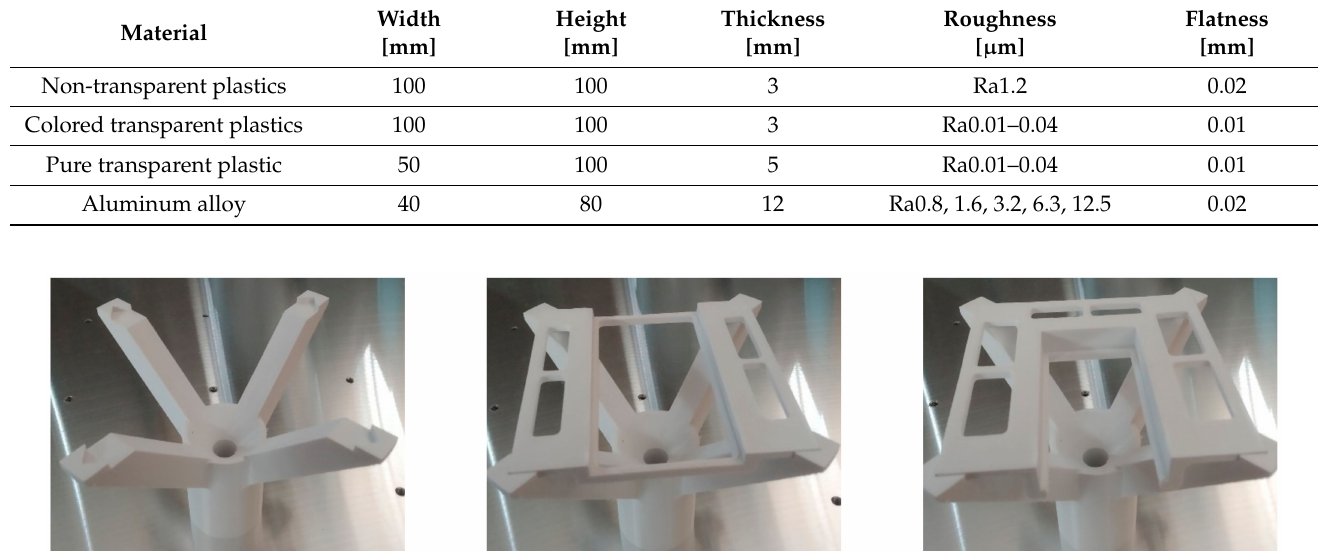
Table 3. Dimensions, surface roughness, and flatness of scanned objects.